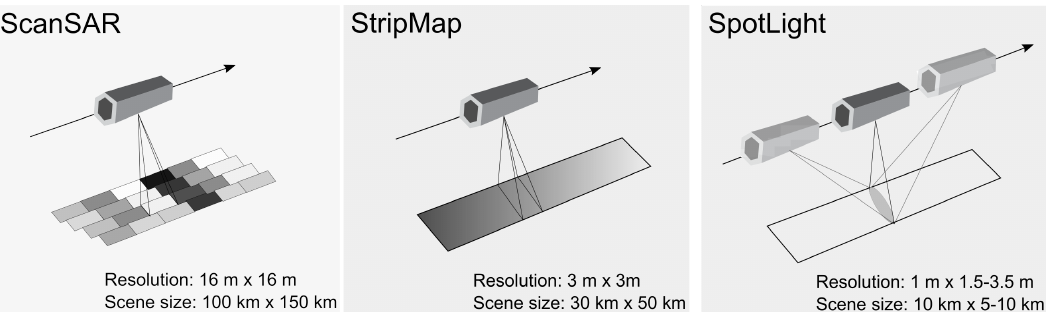
Figure 4. TerraSAR-X basic imaging modes and main configurations [62,63].